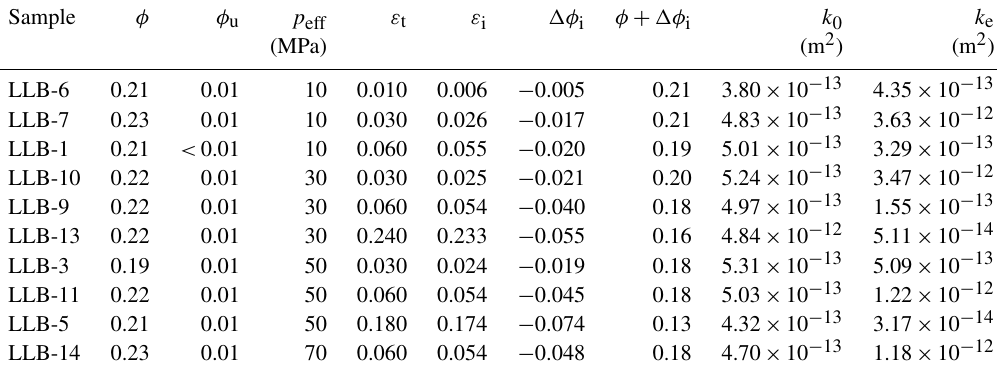
Table 2. Physical property data and deformation conditions for each sample. Samples were deformed under an effective pressure p eff until a total target strain ε t . Then they were unloaded to determine the inelastic strain ε i . Similarly, (cid:49)φ i indicates total porosity change after unloading. p eff is determined by subtracting a constant p p value of 10MPa from the confining pressure p c . Sample φ φ u p eff ε